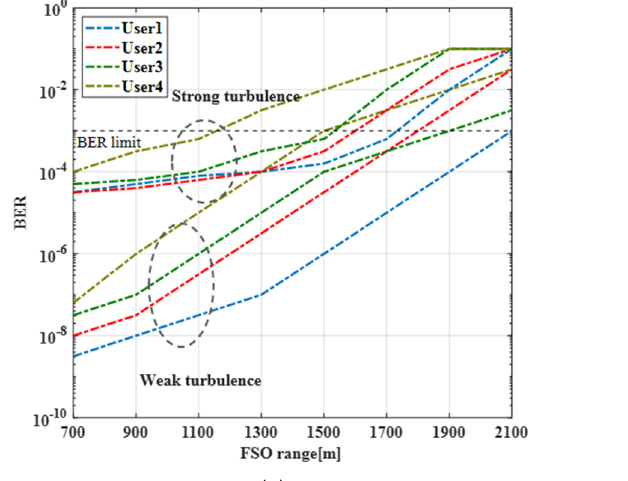
Figure 5. Measured BER under gamma-gamma turbulence modeling. ( a ) Users 1 to 4 operating at Donut mode 0, ( b ) users 5 to 8 operating at Donut mode 1.